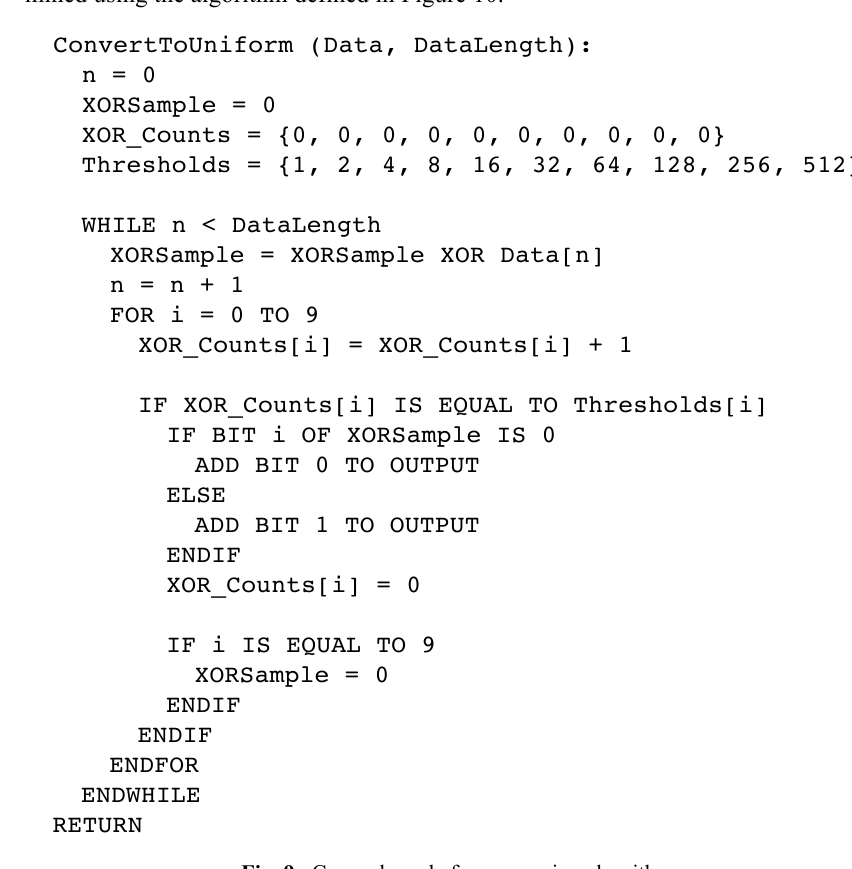
Paper —Using Efficient TRNGs for PSEUDO Profile in National eID Card